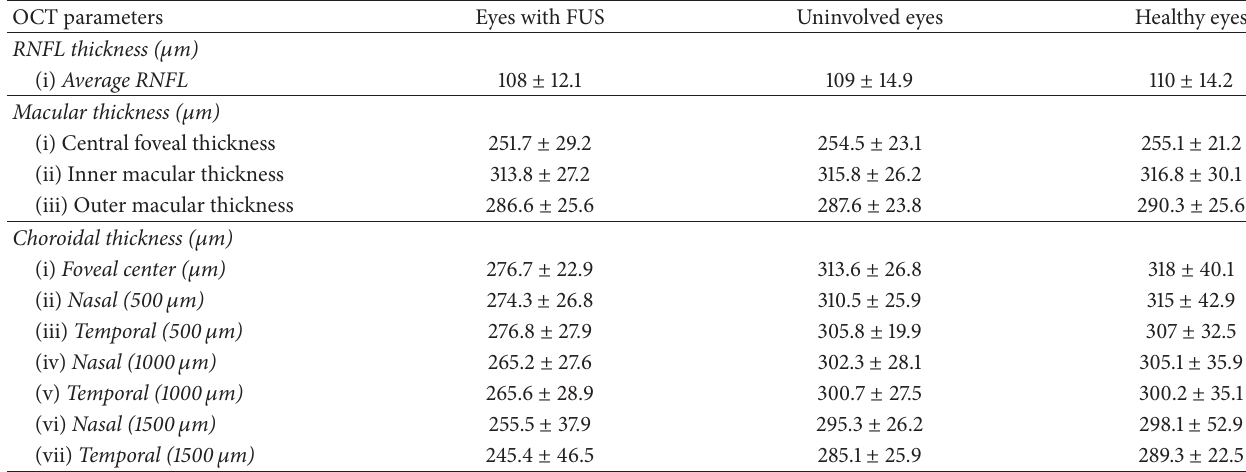
Table 3: Retinal and choroidal thicknesses in patients with FUS and healthy control